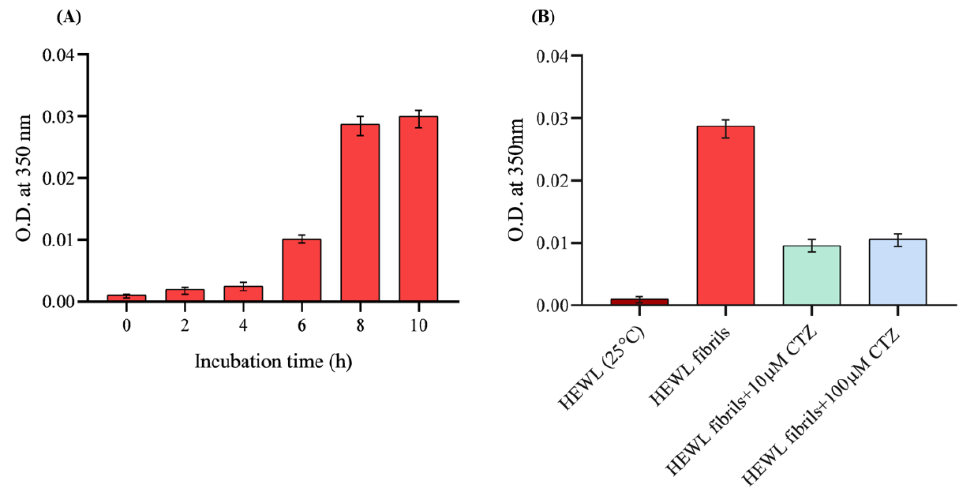
Figure 3. Turbidity measurements by recording the optical density (O.D.) at 350 nm. ( A ) Represents HEWL fibril formation incubated at pH2, 55 ◦ C for 10 h. ( B ) 10 µ M HEWL fibrils incubated for 8 h at 55 ◦ C with 600 rpm agitation the presence and absence at 10 µ M and 100 µ M